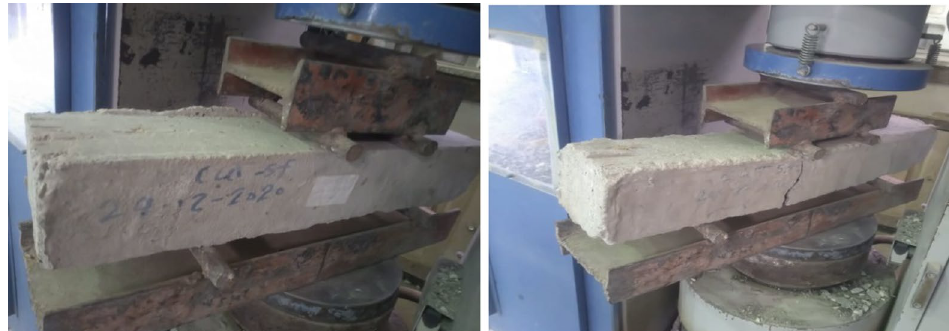
Fig. 16 Flexural test of the beam made from a concrete mixture including SFs and CNTs before and after failure during testing